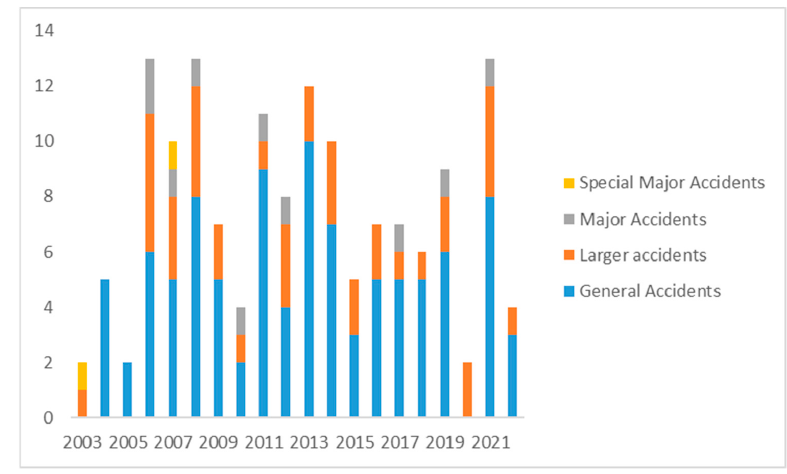
Figure 1. Distribution of safety accidents in tunnel construction from 2003–2022.